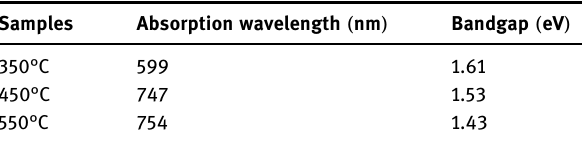
Table 3: The bandgap for CuO samples calcinated at 350, 450, and 550°C Samples Absorption wavelength ( nm